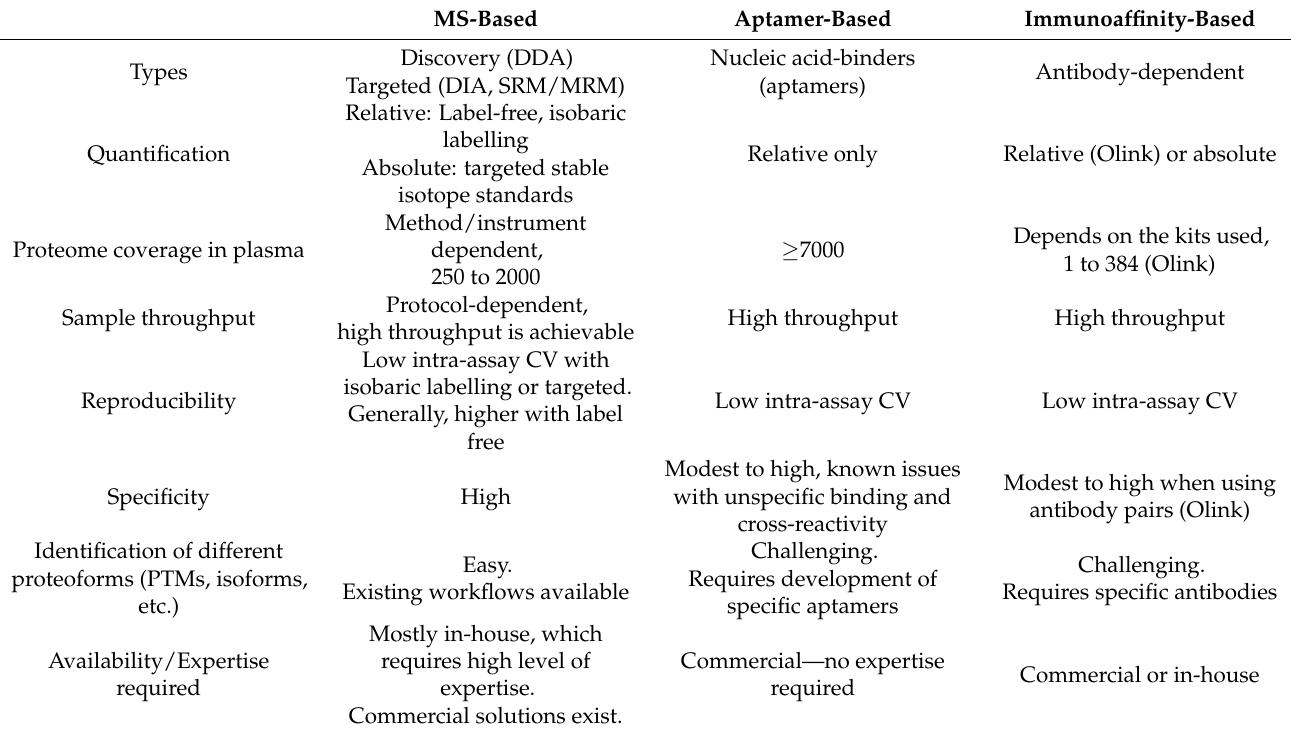
Table 2. Comparison of the current, major plasma proteomics